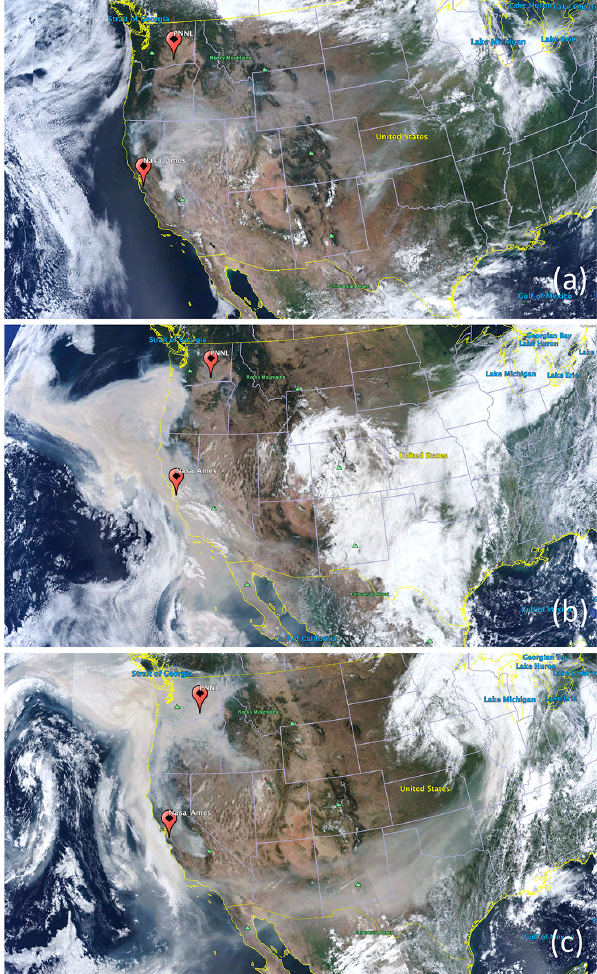
Figure 1. True color images from OMPS onboard Suomi